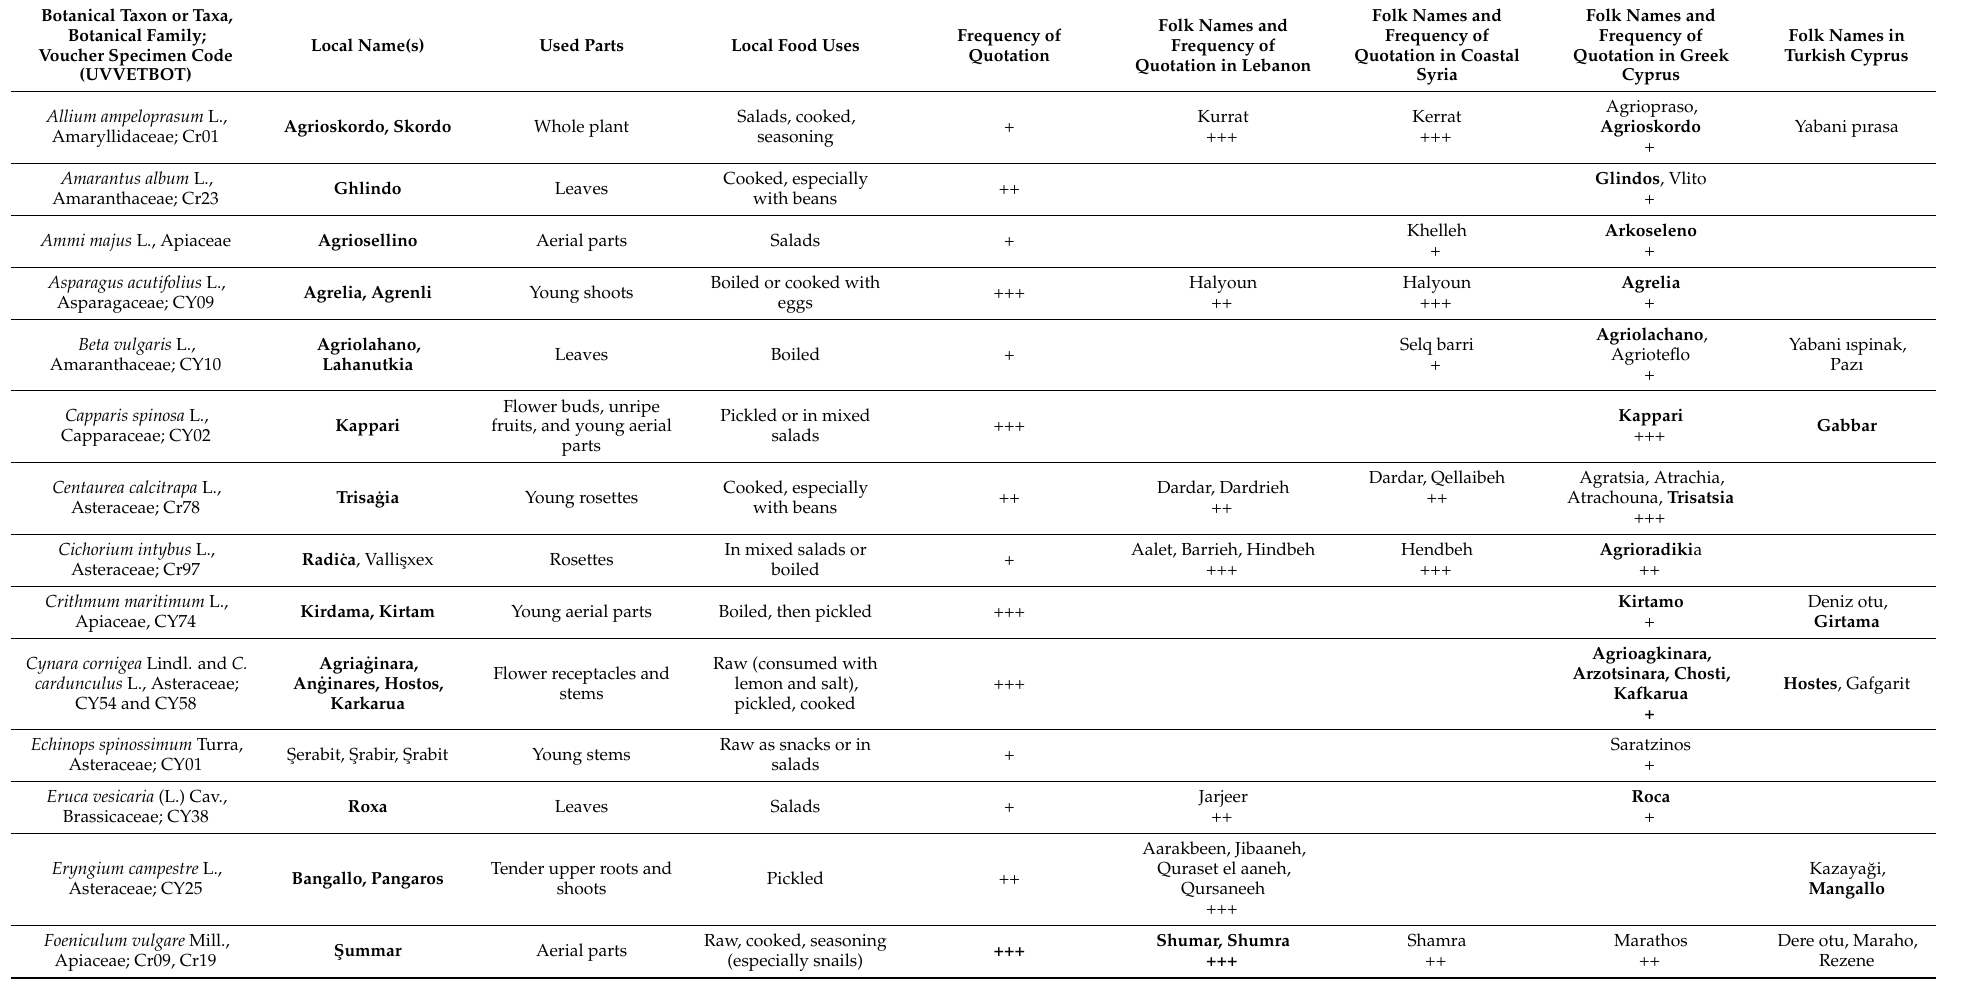
Table 1. Recorded Cypriot Maronite wild vegetables in Kormakitis, including their folk names, local culinary uses, frequency of quotation, and comparison to reports from Lebanon, coastal Syria, and Greek and Turkish